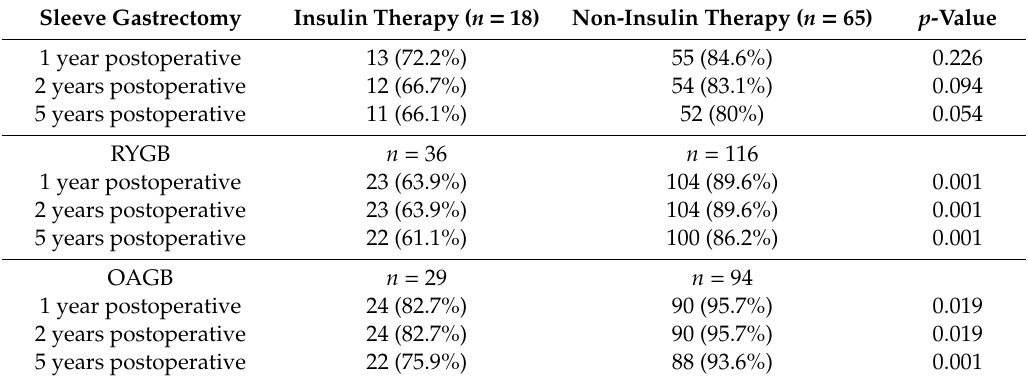
Table 4. Remission of T2D stratified by insulin or non-insulin preoperative treatment.